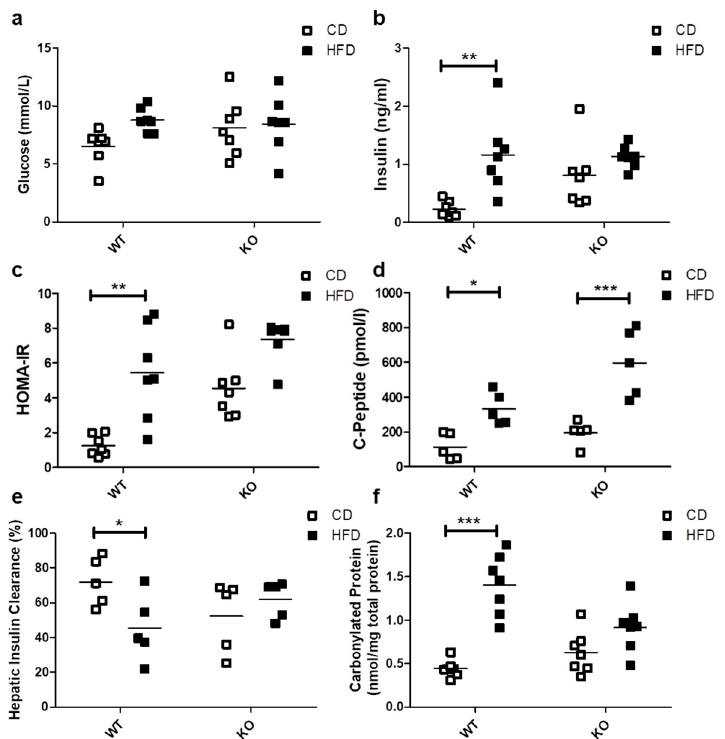
Figure 2. Glucose management, Insulin and C-peptide levels, HOMA-IR, hepatic insulin clearance and oxidative stress in WT and KO mice subjected to CD or HFD. After 12 weeks of diet, blood samples were taken in order to evaluate the serum levels of ( a ) basal glucose ( n = 7), ( b ) basal insulin ( n = 7), ( c ) HOMA-IR ( n = 7), ( d ) basal C-peptide ( n = 5), ( e ) hepatic insulin clearance and ( f ) carbonylated proteins ( n = 7). HOMA-IR (Homeostatic Model Assessment of Insulin Resistance) adjusted for mice ( n = 7) were calculated from basal glucose and insulin levels. Hepatic insulin clearance was calculated from the basal insulin / C-peptide ratio ( n = 5). Mice were maintained for 6 h in fasting conditions before blood samples were taken. p values were calculated by two-way ANOVA with a Bonferroni post-test (* p < 0.05, ** p < 0.01, *** p < 0.001). Data are presented as individual data points with